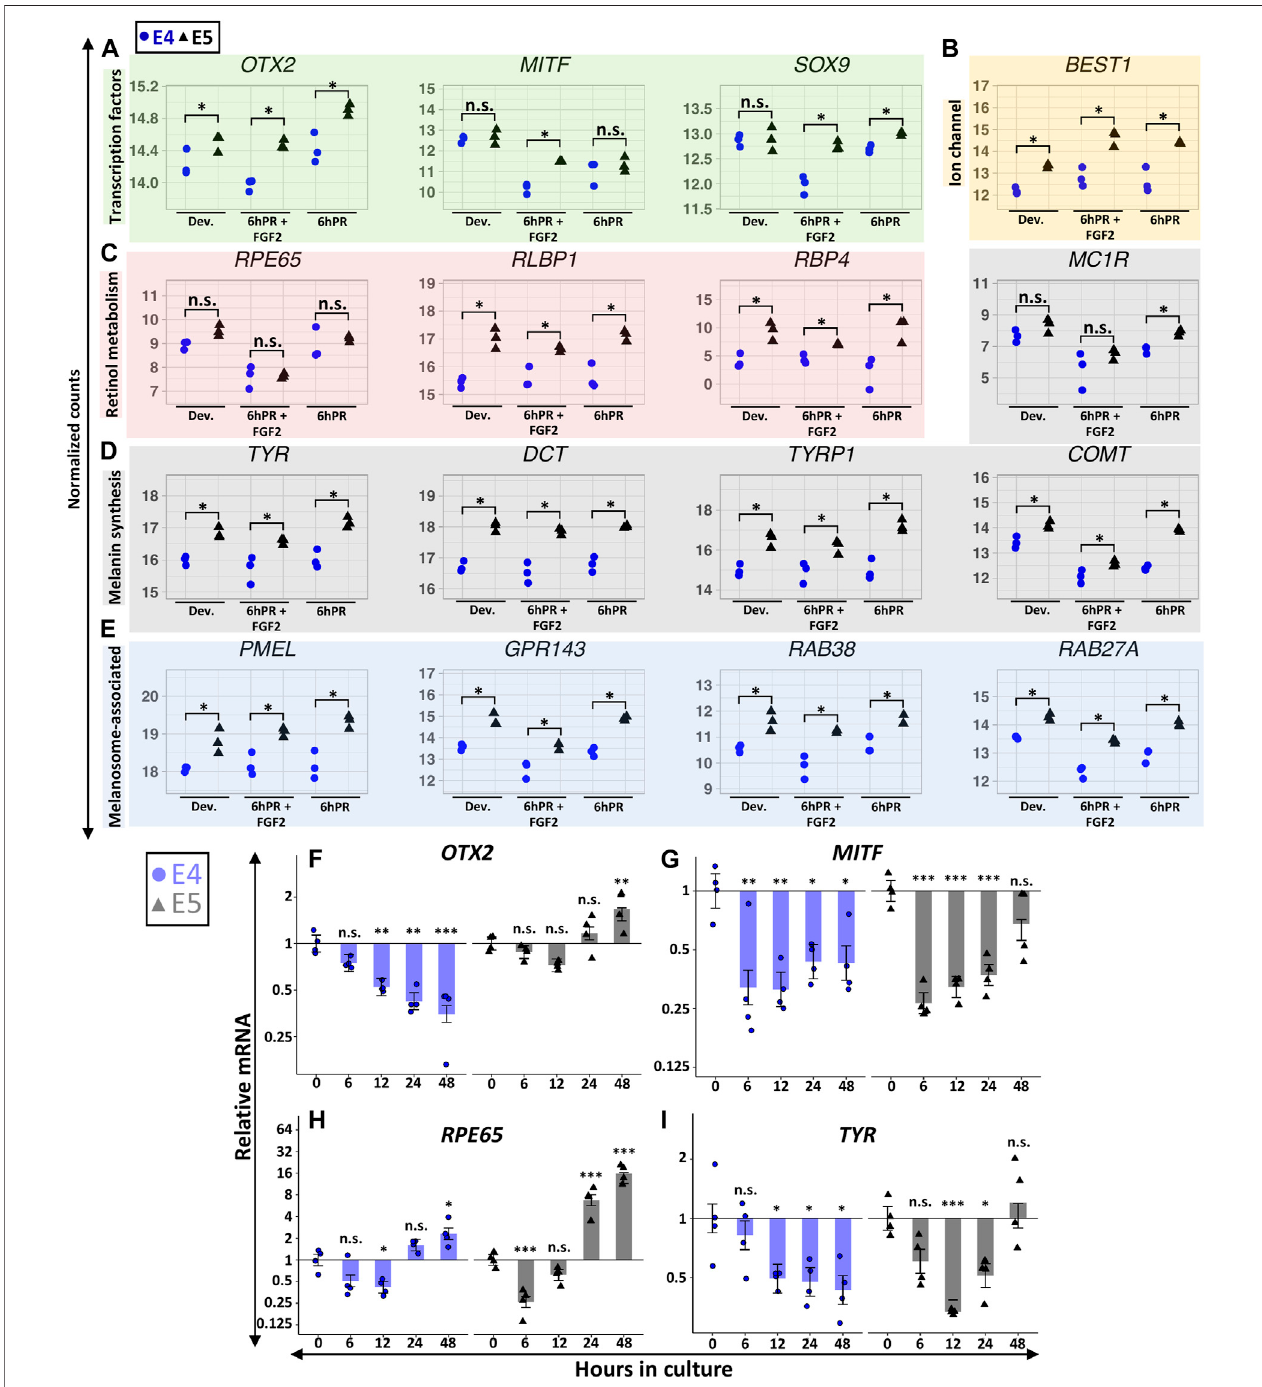
FIGURE 5 | Gene signatures associated with RPE maturation are broadly elevated in the E5 RPE. Normalized RNA-seq expression values are displayed for genes encoding RPE-associated transcription factors (A) , the ion channel BEST1 (B) , retinol metabolism and transport factors (C) , melanin synthesis machinery (D) , and melanosome-associated proteins (E) . For (A – E) , asterisk (*) denotes an Adj. p -value ≤ 0.05 and n.s., not signi fi cant. Relative gene expression was measured in RPE explantsusing RT-qPCR, and isdisplayedfor OTX2 (F) , MITF (G) , RPE65 (H) ,and TYR (I) . Bar chart displays the average expression, and theerror bars represent standard error of the treatment mean based on ANOVA. Each dataset is normalized to basal levels observed at time 0; y -axes are log 2 -transformed. qPCR signi fi cance: n.s. denotes not signi fi cant, * denotes p -value < 0.05, ** denotes p -value < 0.01, *** denotes p -value < 0.001.